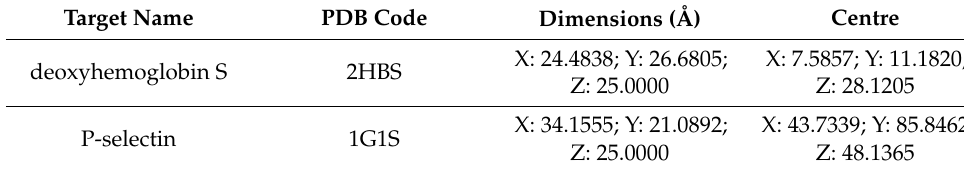
Table 2. Docking